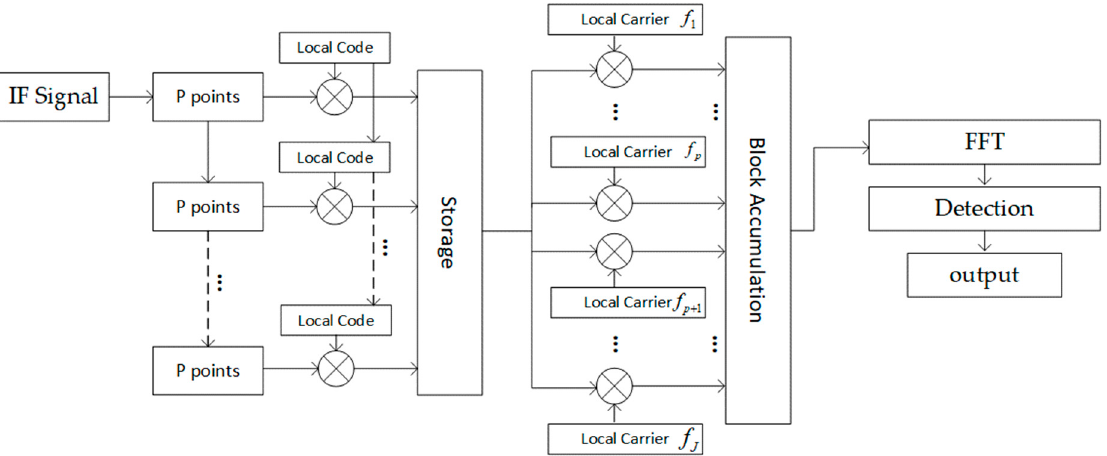
Figure 5. Structure of the PMF-FC-BA-FFT acquisition method.